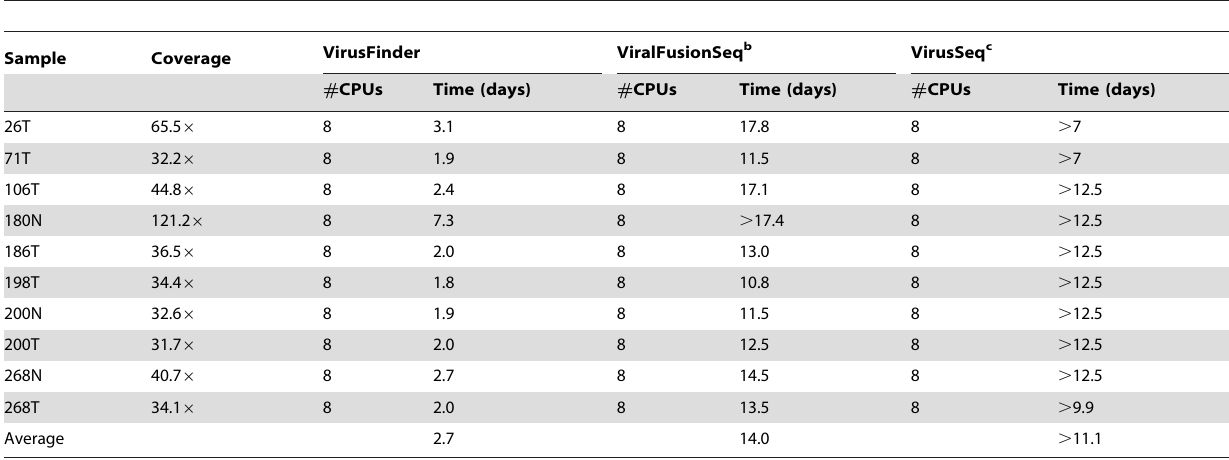
Table 3 . Comparison of computation time of three virus integration-detecting methods on whole genome sequencing (WGS) data a